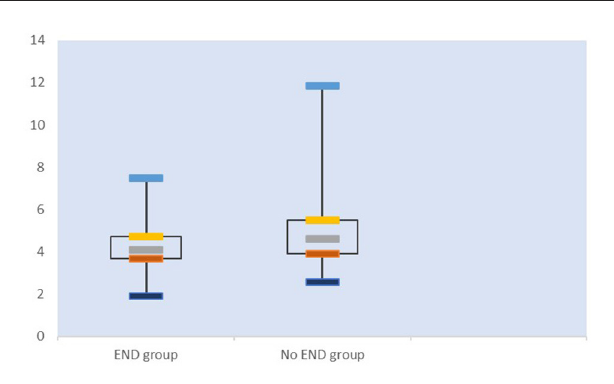
FIGURE4 Whisker plots of SUA/SCr in the END and No-END groups.